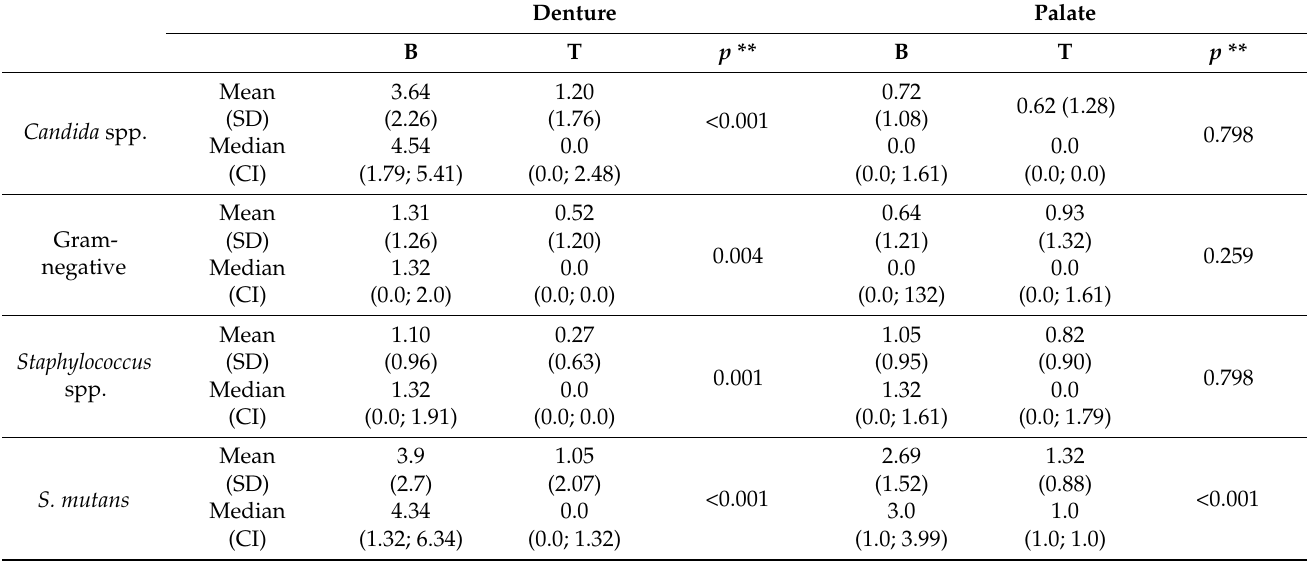
Table 4. CFU counts of Candida spp., Gram-negative bacteria, Staphylococcus spp., and S. mutans at the baseline (B) and after treatment